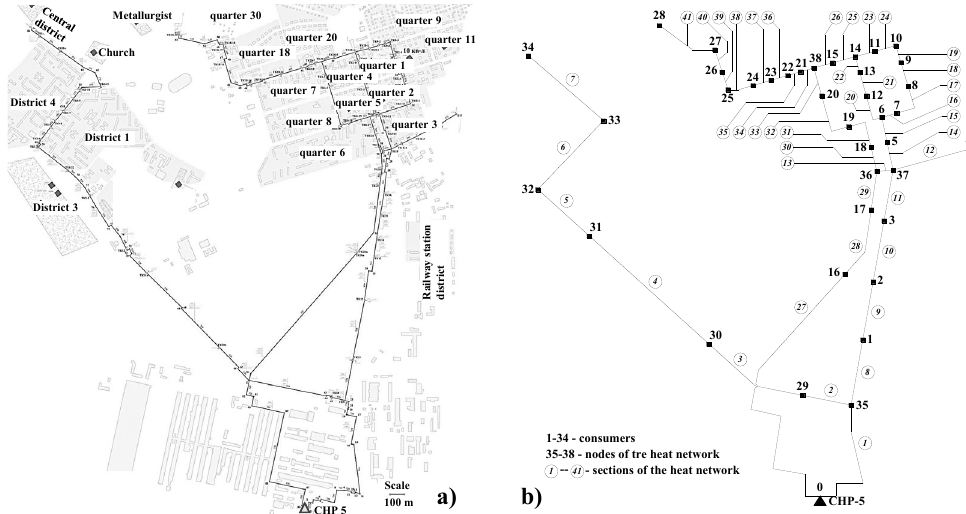
Fig. 1. Schemes of DHS in Shelekhov: a) general scheme on the city map; b) aggregated calculated scheme.